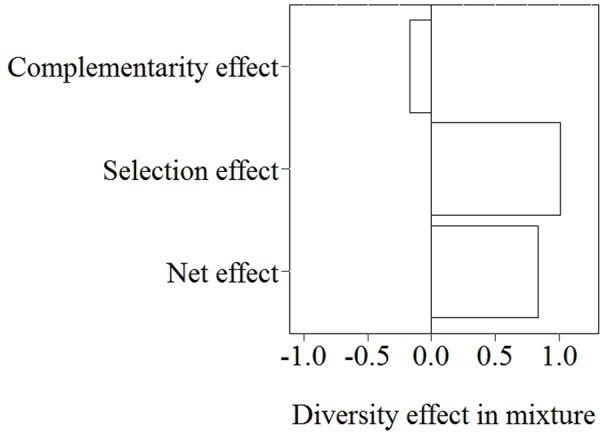
Partitioning of the diversity effect on native community biomass of the highest species richness level (4 species) into a complementarity effect and a selection effect by applying the additive partitioning diversity effect method proposed by Loreau and Hector (2001).